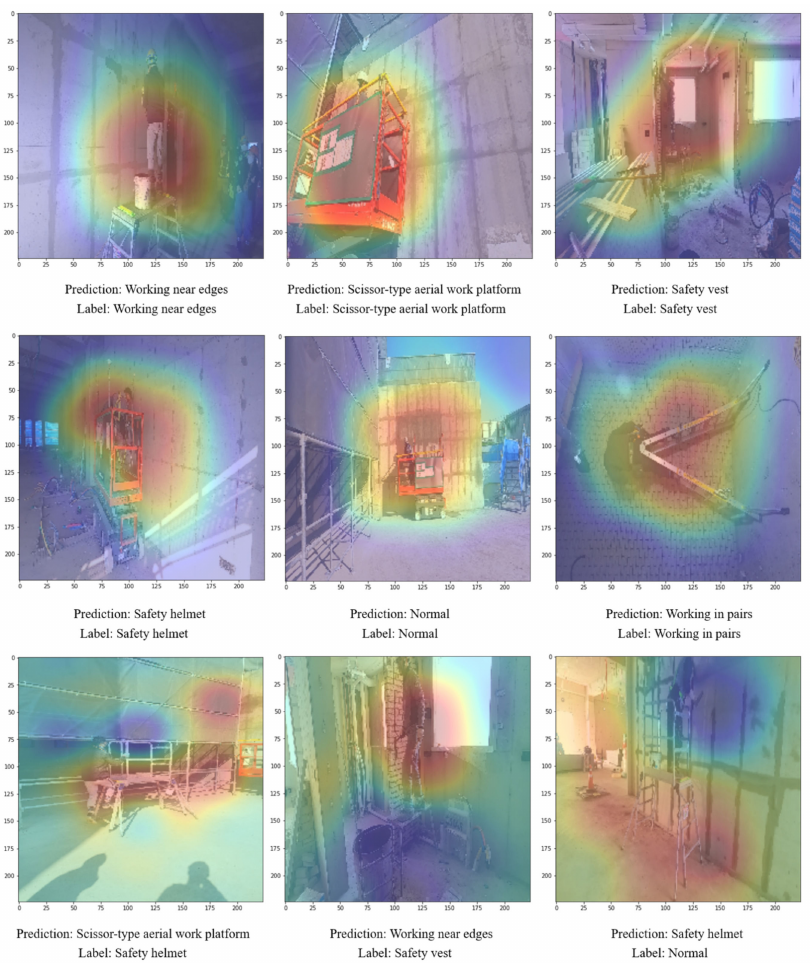
Figure 4. Visualization results using